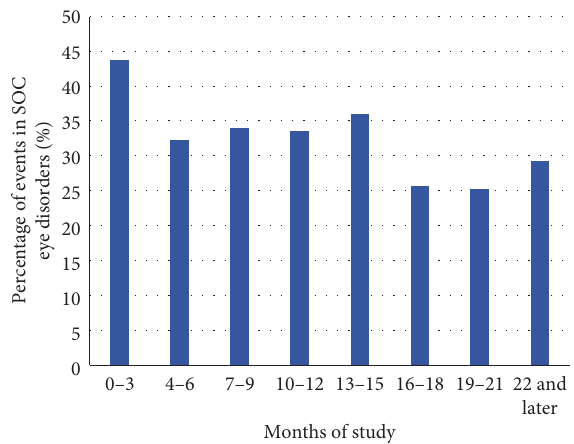
Figure 5: Percentages of adverse events in the MedDRA SOC Eye disorders, over the course of the study. No increase in the pro- portion of eye disorders was observed over the course of the study. Percentages were calculated based on the total number of events in the respective time period. AE, adverse event; MedDRA, Medical Dictionary for Regulatory Activities; SOC, System Organ Class.